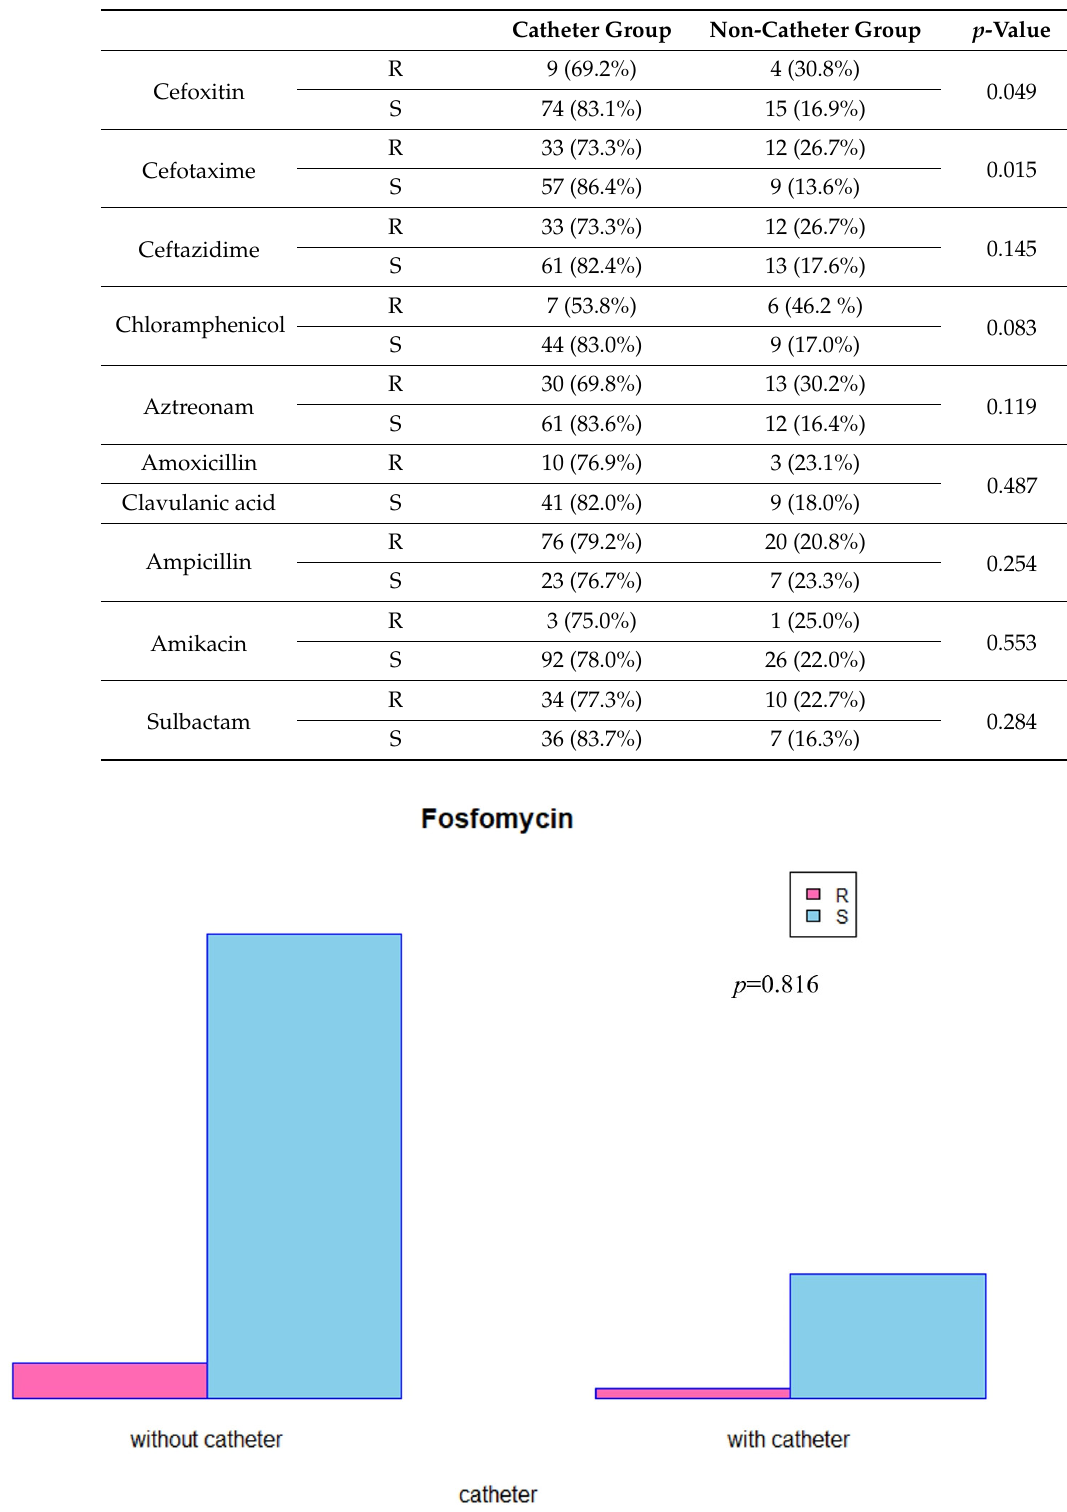
Figure 1. Fosfomycin antibiotics sensitivity according to catheter